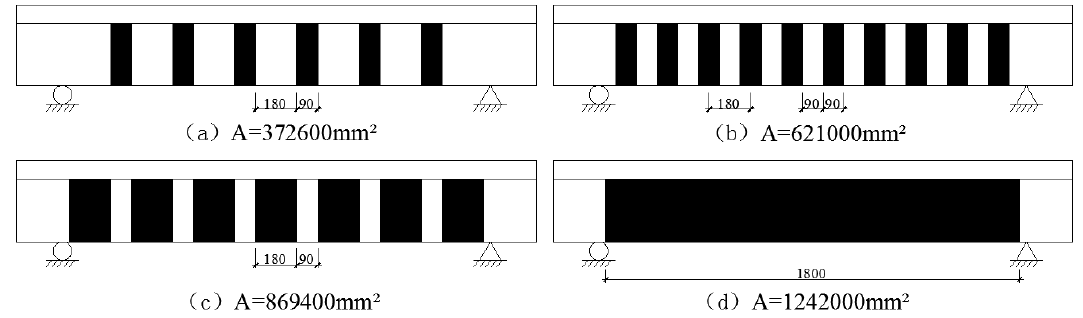
Figure 14. Four kinds of CFRP strengthening sizes.